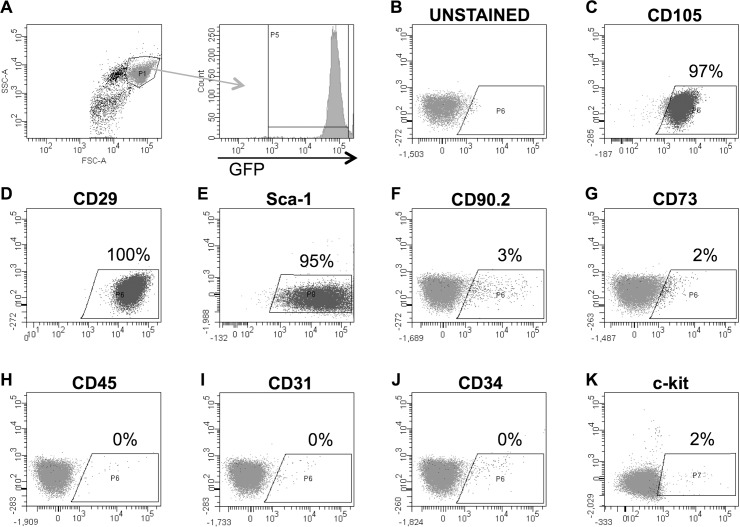
Flow cytometric characterization of Sca-1+/lin- murine cardiac cells.
A, B: Gating strategy, and C-K: flow cytometric analyses for C: CD105, D: CD29, E: Sca-1, F: CD90.2, G: CD73, H: CD45, I: CD31, J: CD34, and K: c-kit.